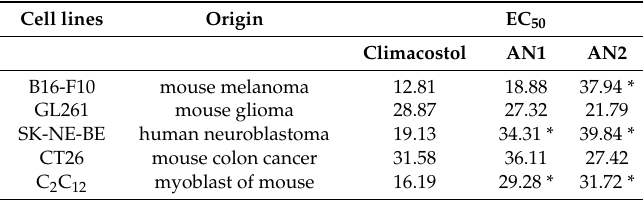
Table 1. Induction of inhibition of cell viability by means of climacostol and its analogues. EC 50 ( µ g / mL) = the concentration producing half of the maximum e ff ect. Original data from [31].